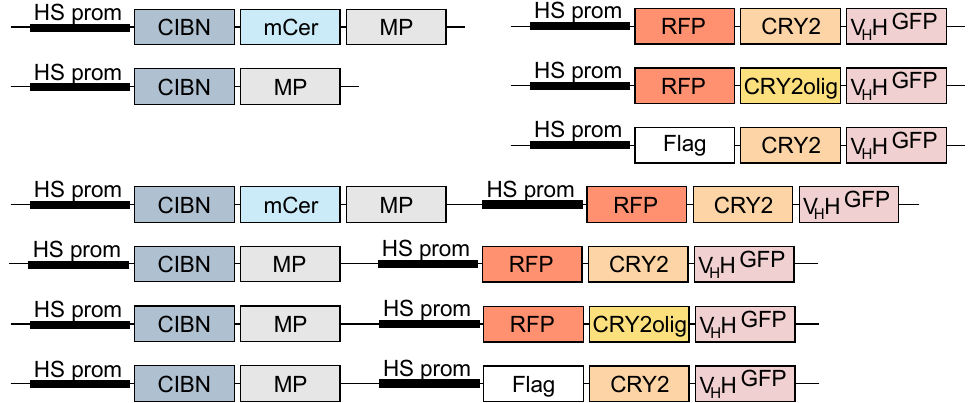
Figure 2. Schematic representation of LARIAT plasmids for Drosophila Schneider 2 (S2) cells. LARIAT modules were cloned downstream of the Hsp70 promoter. Untagged and mCerulean-tagged CIBN are fused with the MP. Flag- or red fluorescence protein (RFP-) tagged CRY2 photolyase homology region are fused with an anti-GFP nanobody (V H H GFP ). CRY2olig oligomerization ability is enhanced due to a single point mutation—E490G. Different CRY2 and CIBN expression cassettes were combined in the same vectors for efficient co-expression. Table 1. List of primers for molecular cloning.